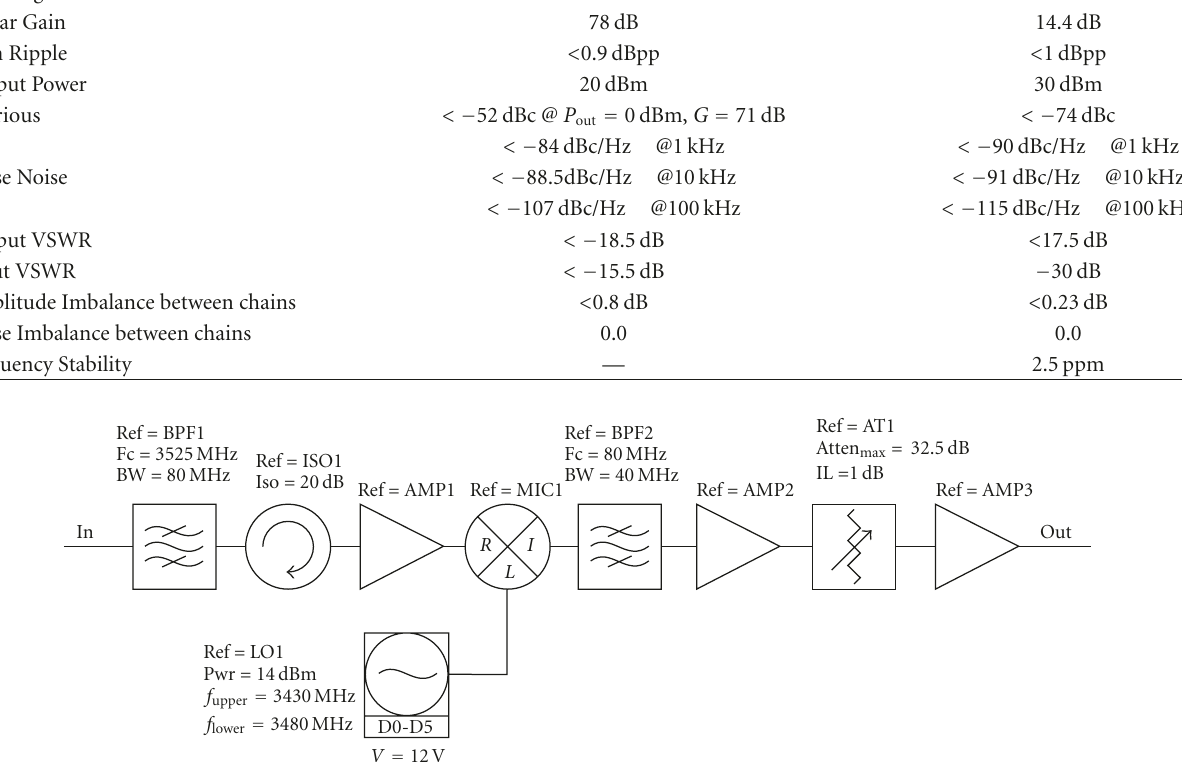
Figure 3: Radio Frequency Chain RX Modules